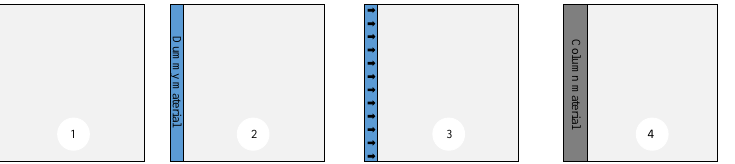
Figure 5. Calculation phase to simulate the column installation process: ( 1 ) initial phase; ( 2 ) create a hole and insert dummy; ( 3 ) applied displacement; ( 4 ) insert column material and